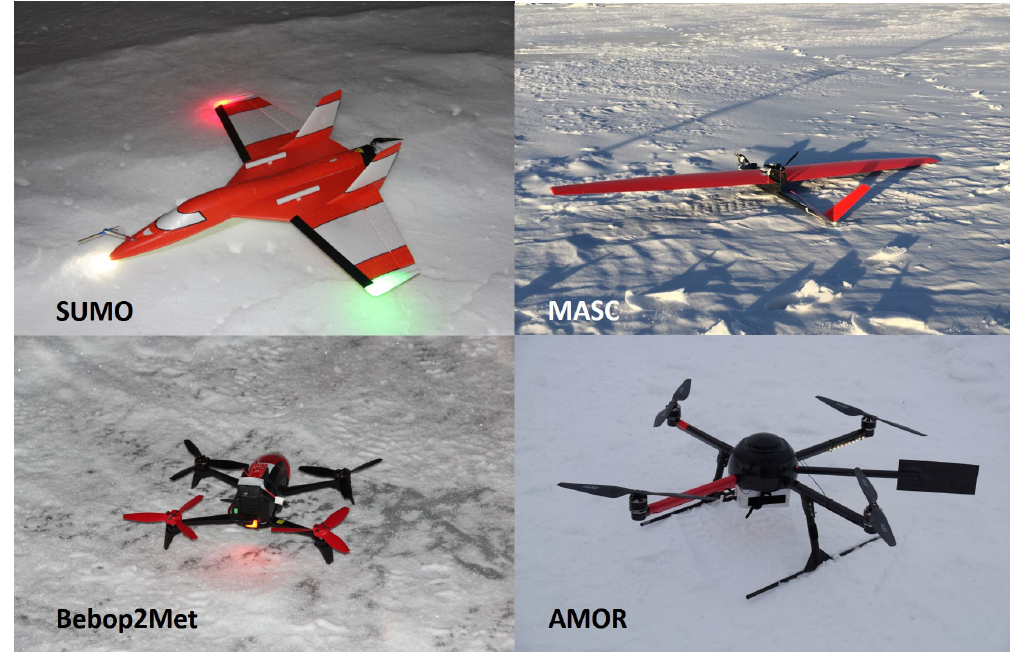
Figure 2. UAV systems used during the Hailuoto-I campaign.